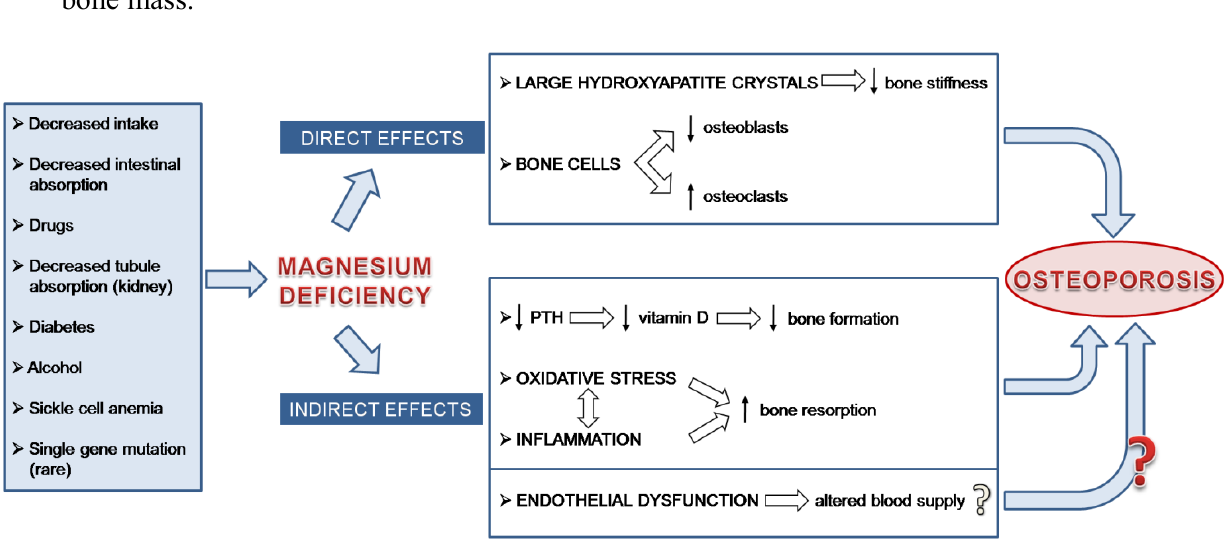
Figure 1. Present knowledge about the mechanisms involved in linking Mg deficiency and osteoporosis. Remarkably, similar events are implicated in experimental models and in humans. Because the vasculature plays an important role in bone remodeling, we also hypothesize that low Mg induced-endothelial dysfunction contributes to the decline of bone